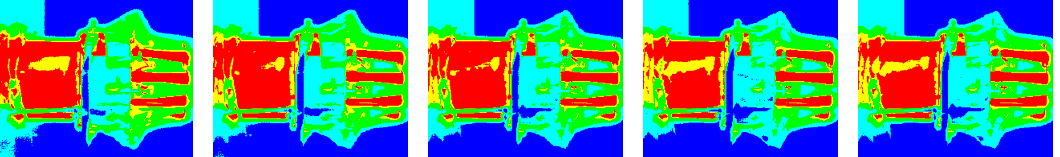
Figure 16. The size S i of each segmented area for five example points. 3.2. Classification System Testing and Results To validate the ability of the trained Kohonen network to segment the thermal image, a system for its evaluation was designed as follows. Five artificial spheres, each with an area of 150 pixels, were created, each of which fell into only one of the classes. As can be seen in Figure 17, the network was able to correctly classify these artificial anomalies in this particular case. In order to properly evaluate the functionality of the classifier, five testing infrared images were divided into 60 segments. The artificially created spherical temperature field anomaly for each class was moved across all segments, giving a total of 300 testing images for each class and 1500 testing images in total. The division of the image into segments when the artificial anomaly was included is shown in Figure 18.